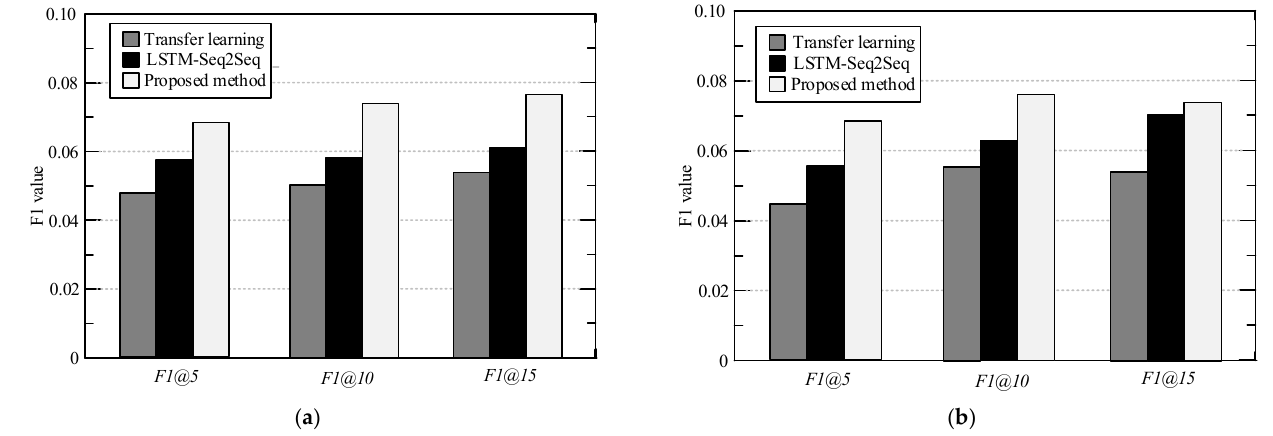
Figure 5. F1 Comparison results of different methods on different data sets. ( a ) loc-Gowalla ( b ) loc-Brightkite.